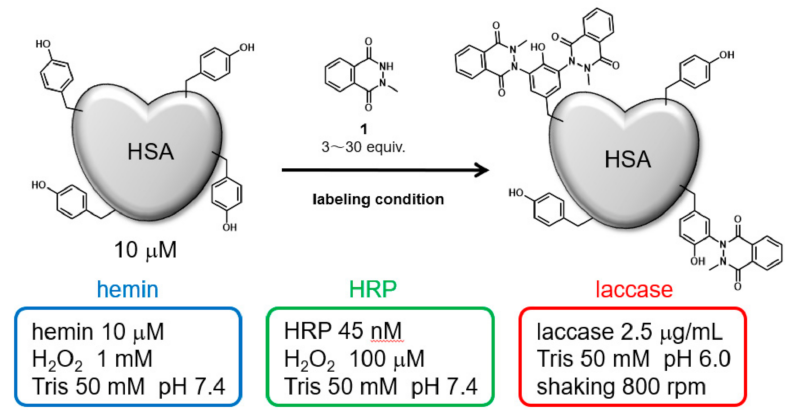
Figure 1. HSA modification by N -methylated luminol derivative ( 1 ) and three catalytic reaction